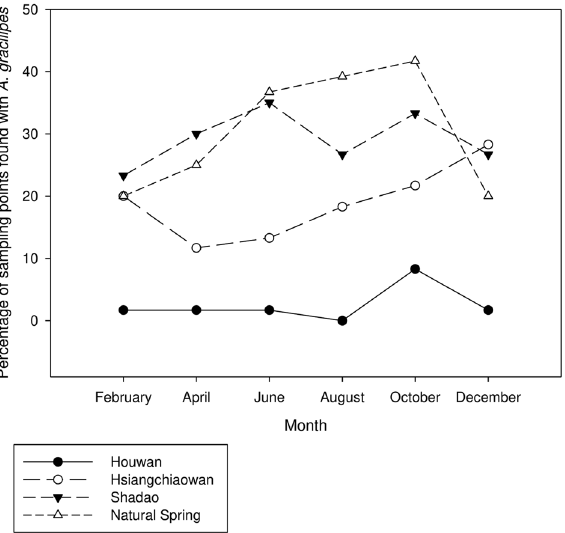
Figure 3. Differences in the percentage of sampling points found positive for Anoplolepis gracilipes at the four study sites throughout the study period.